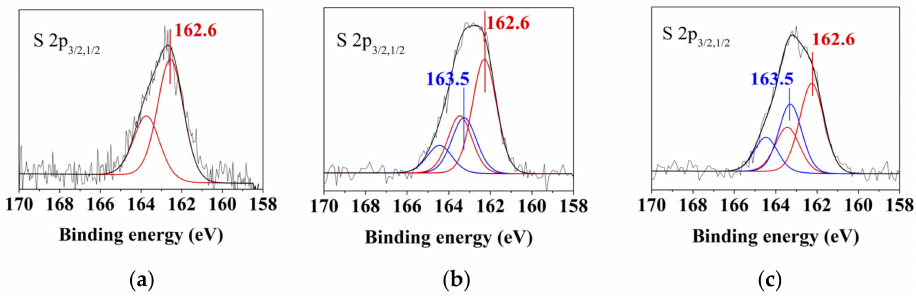
Figure 8. Photoelectron S 2p spectra of CoFe 2 O 4 /Au nanoparticles synthesized under the conditions in Figure 3: ( a ) 1 gold deposition cycle, ( b ) 6 gold deposition cycles and ( c ) 10 gold deposition